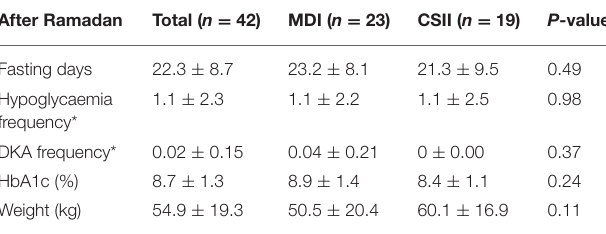
TABLE 3 | After Ramadan values on fasting days, hypoglycaemia and DKA frequency, HbA1c, and weight: MDI and CSII compared. After